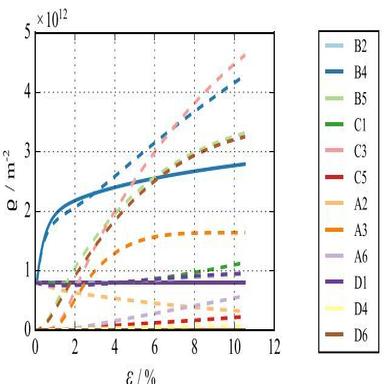
Dislocation density evolution of individual glide systems as a function of strain for the tensile tests shown in. Dashed lines represent the enhanced model including dislocation multiplication by glissile junction formation. New glide systems are populated and contribute to the plastic deformation as opposed to the original model, where only glide system B4 shows an increase in dislocation density and contributes to plastic deformation. For legend notation see Figure adopted from